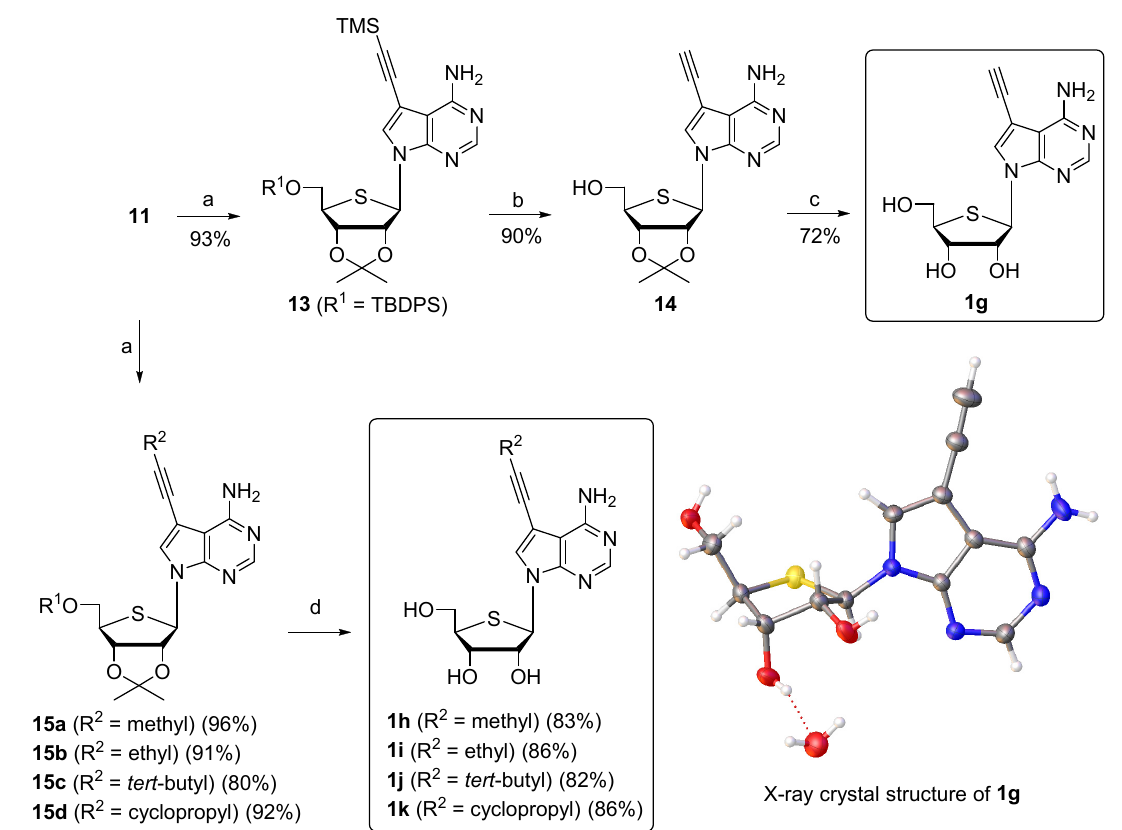
Scheme 3. Synthesis of 7-substituted 7-deaza-4’-thioadenosine derivatives 1g–k . Reagents and conditions: (a) corresponding alkyne, PdCl 2 (PPh 3 ) 2 , CuI, Et 3 N, DMF, MW, 50 °C, 1 h; (b) 1 M TBAF, THF, rt, 40 min; (c) 2 N HCl, THF, rt, 15 h; (d) 50% TFA/H 2 O, THF, rt, 12 h.